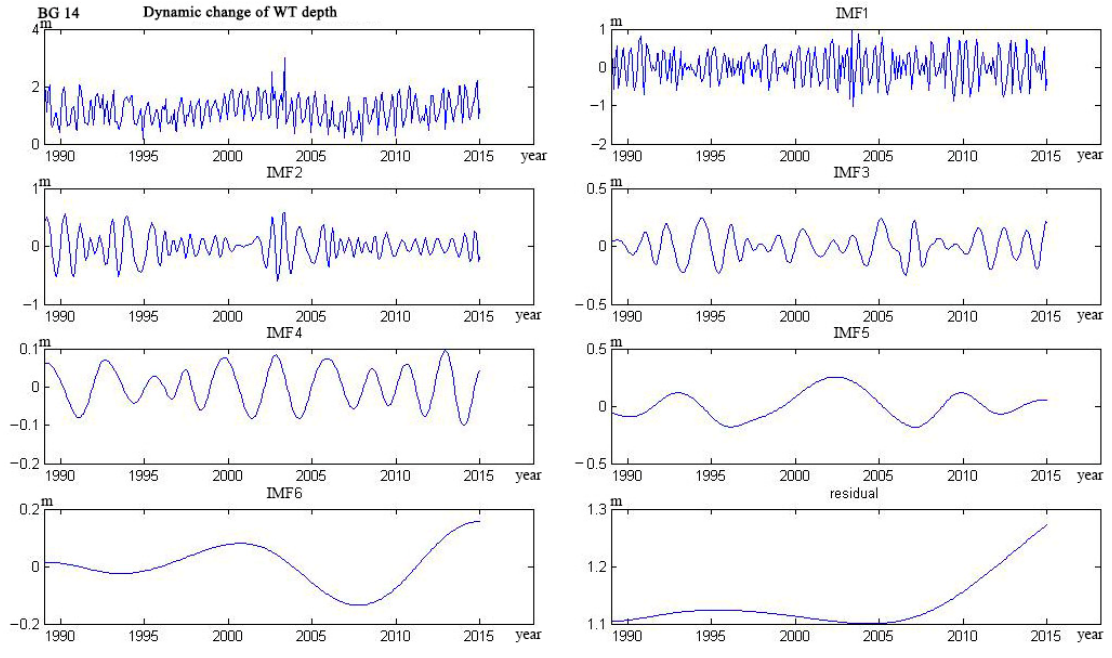
Figure A10. Decomposition of groundwater time series data of well BG13.